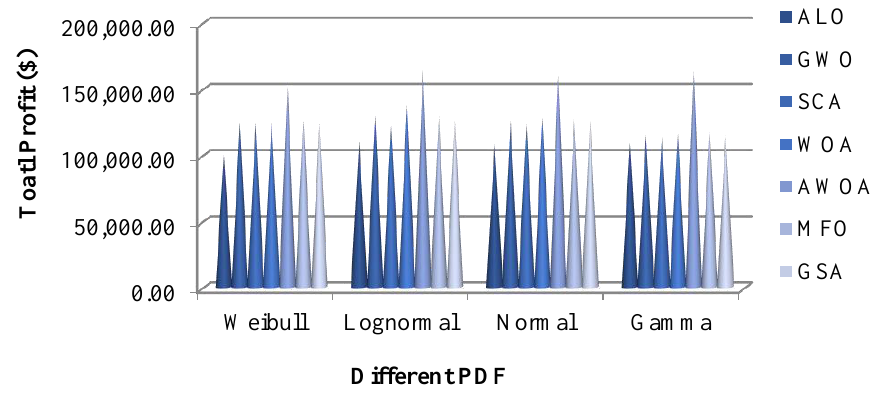
Figure 18. Total Profit of 24 Hours Using Different Approaches.